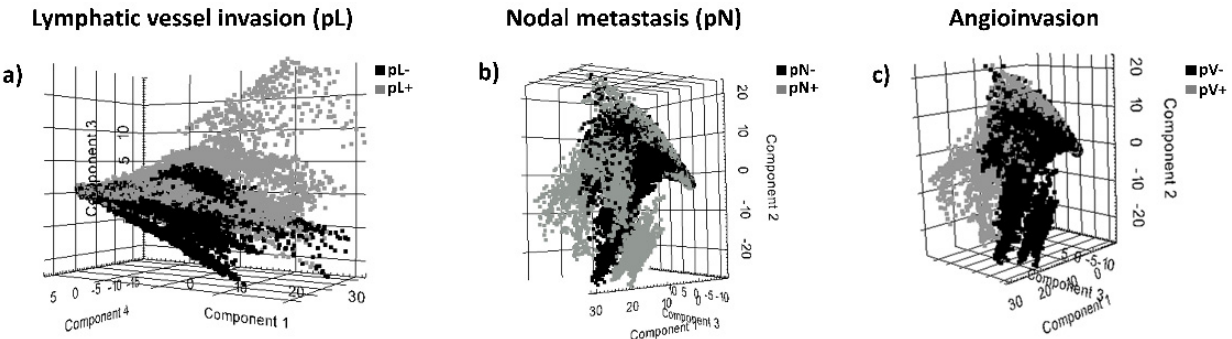
Figure 1. Principal component analysis (PCA) of MALDI-MSI data showing a discrimination of peptide signatures of tumors in terms of absence or presence of the prognostic histopathological features ( a ) lymphatic vessel invasion (pL+ vs. pL − ), ( b ) nodal metastasis (pN+ vs. pN) and ( c ) angioinvasion (pV+ vs. pV − ) .